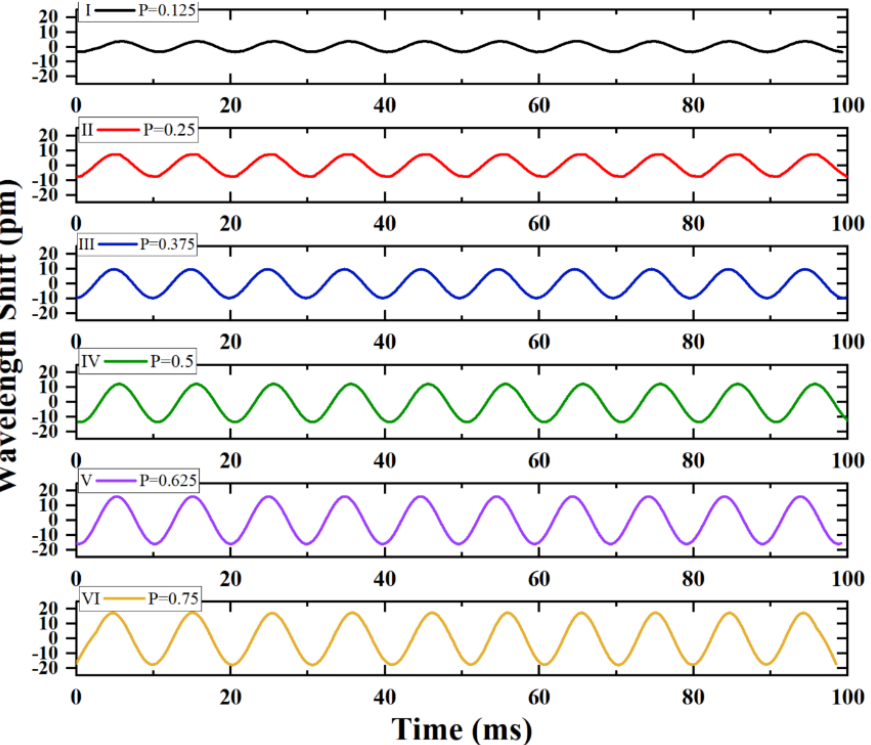
Figure 4. Time response capability of accelerometers 1–6 under a sinusoidal excitation signal with a vibration frequency of 100 Hz and vibration acceleration of 0.5 g. Table 1. Performance of the six accelerometers.